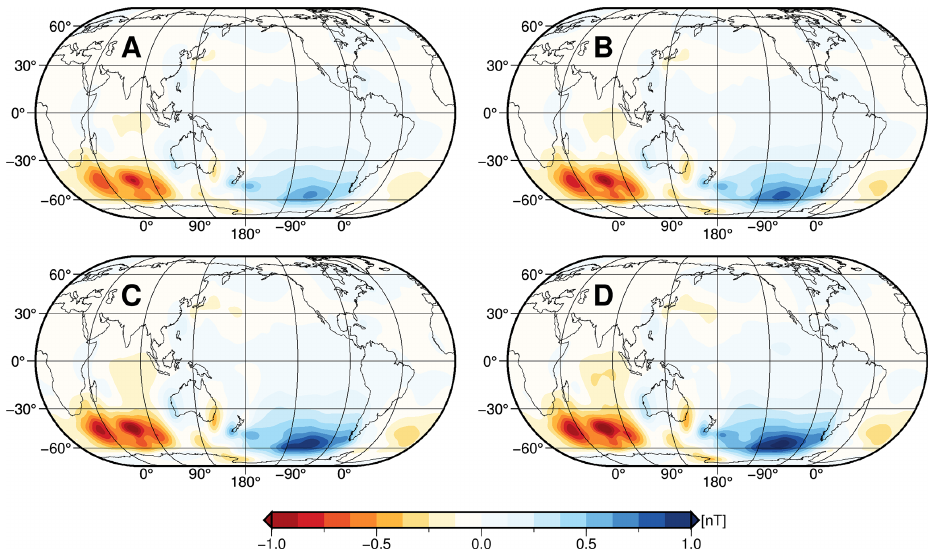
Figure A2. Annual mean ocean-induced magnetic field at satellite altitude (430km) for scenarios A, B, C, and D with layer thicknesses of 1050, 1450, 2100, and 3000m,